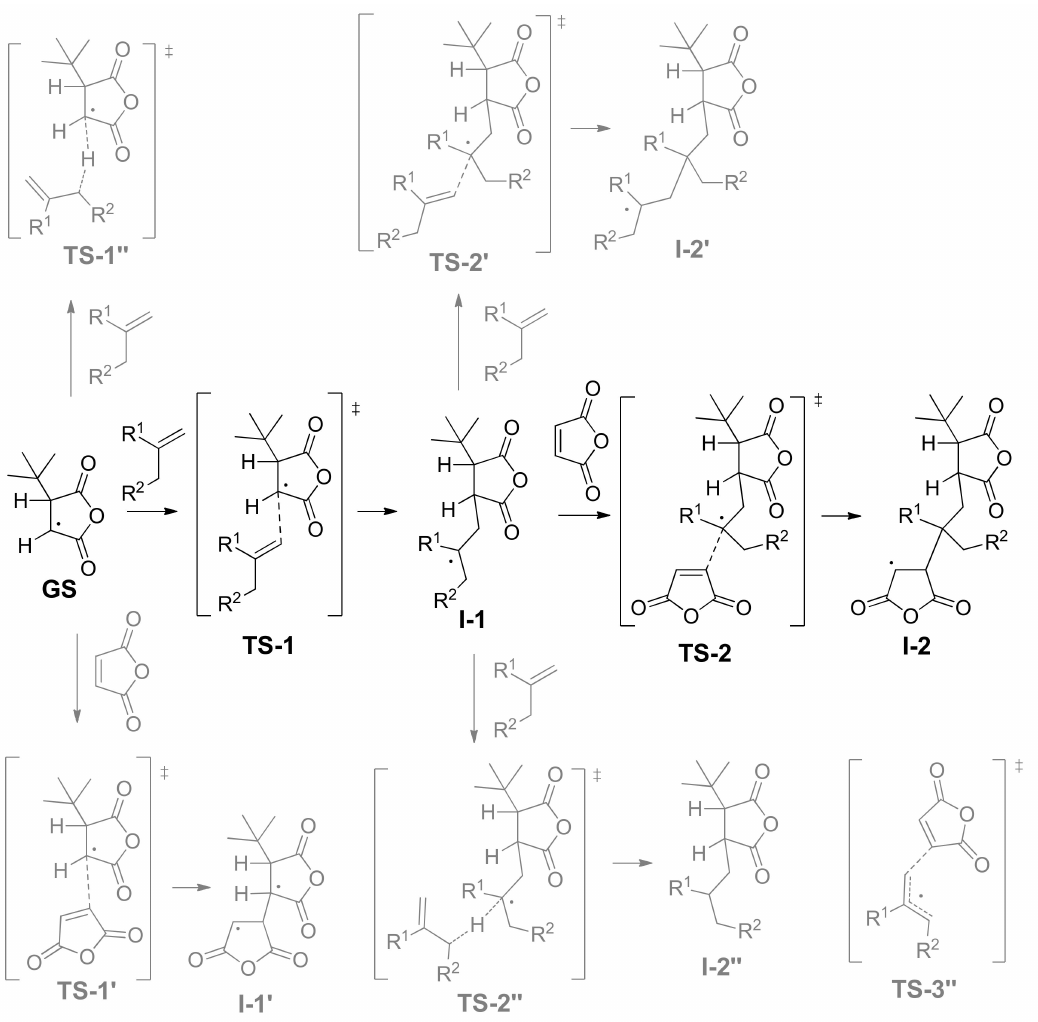
Scheme 4. The main (marked in black) and side (marked in gray) model reactions for radical copolymerization of MA with